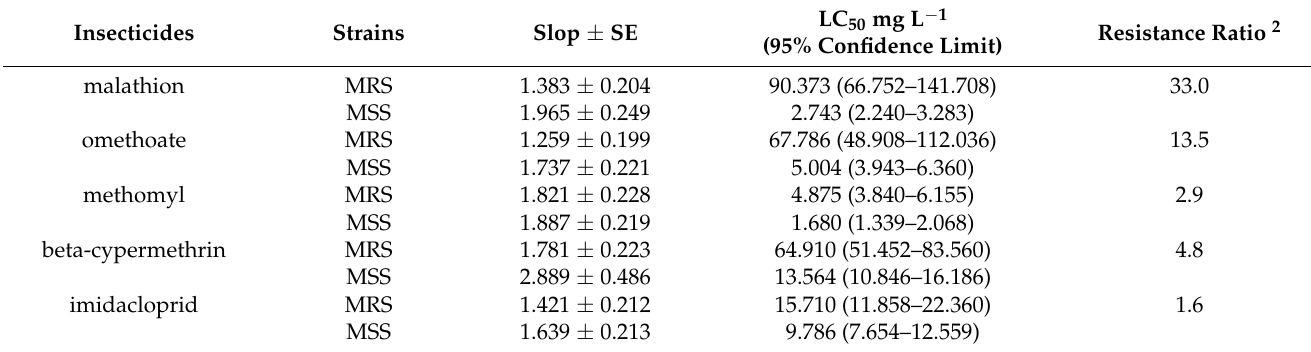
Table 2. Responses to other insecticides in malathion-selected population of S. miscanthi 1 . Insecticides